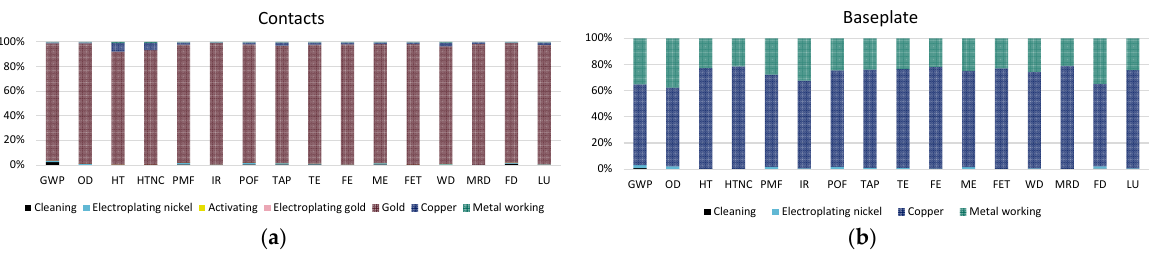
Figure 8. Standardized environmental impacts of contact ( a ) and baseplate ( b ) processes for the power module (150 kW), given the European Commission recommendations for choosing impact categories [27]. Abbreviations are presented in Table 1.